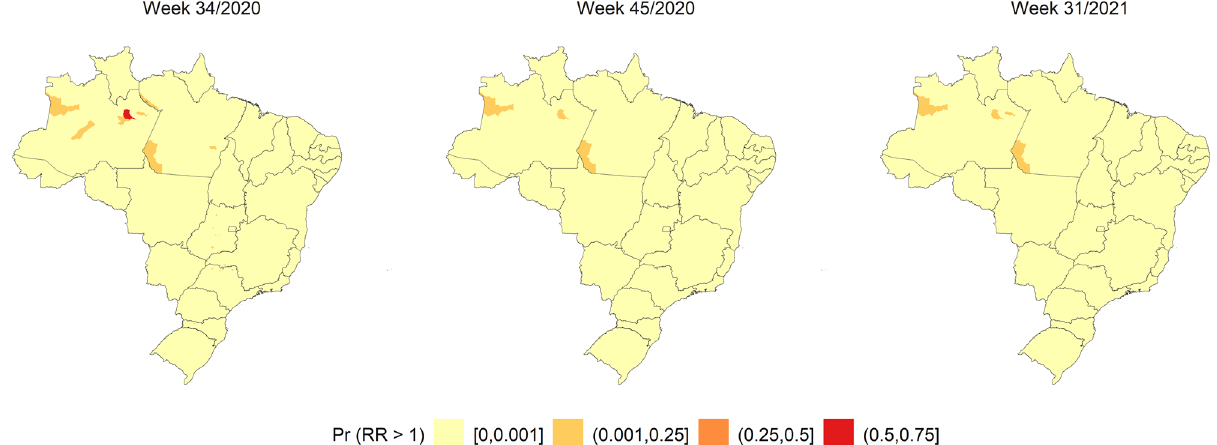
Figure 9. Relative risk of the ZINB spatial–temporal regression models for the standardised case fatality ratio of severe acute respiratory syndrome coronavirus 2 in weeks 15/2020, 30/2021, 45/2020, 7/2021, 22/2021, and 38/2021. The map was generated using public domain shapefiles provided by the Brazilian Institute of Geography and Statistics (https:// geoftp. ibge. gov. br/ organ izacao_ do_ terri torio/ malhas_ terri toria is/ malhas_ munic ipais/ munic ipio_ 2021/ Brasil/ BR/ BR_ Munic ipios_ 2021. zip). The figure was generated by the authors using the R 4.0.5 software 9 and the packages ggplot2 10 , sf 11 and tidyverse 12